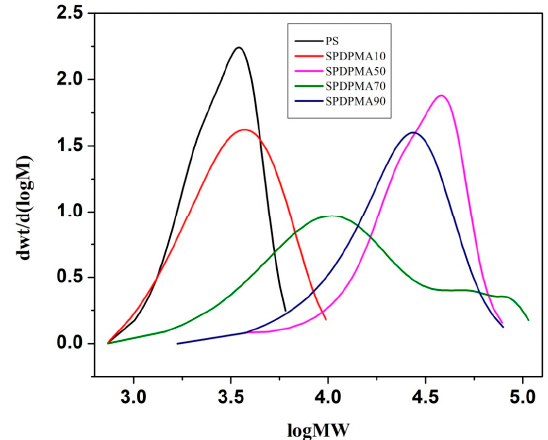
Figure 4. dwt/dlogM vs. log M w plots of styrene-PDPMA copolymers showing variation in mol.wt. distribution as a function of the feed composition.